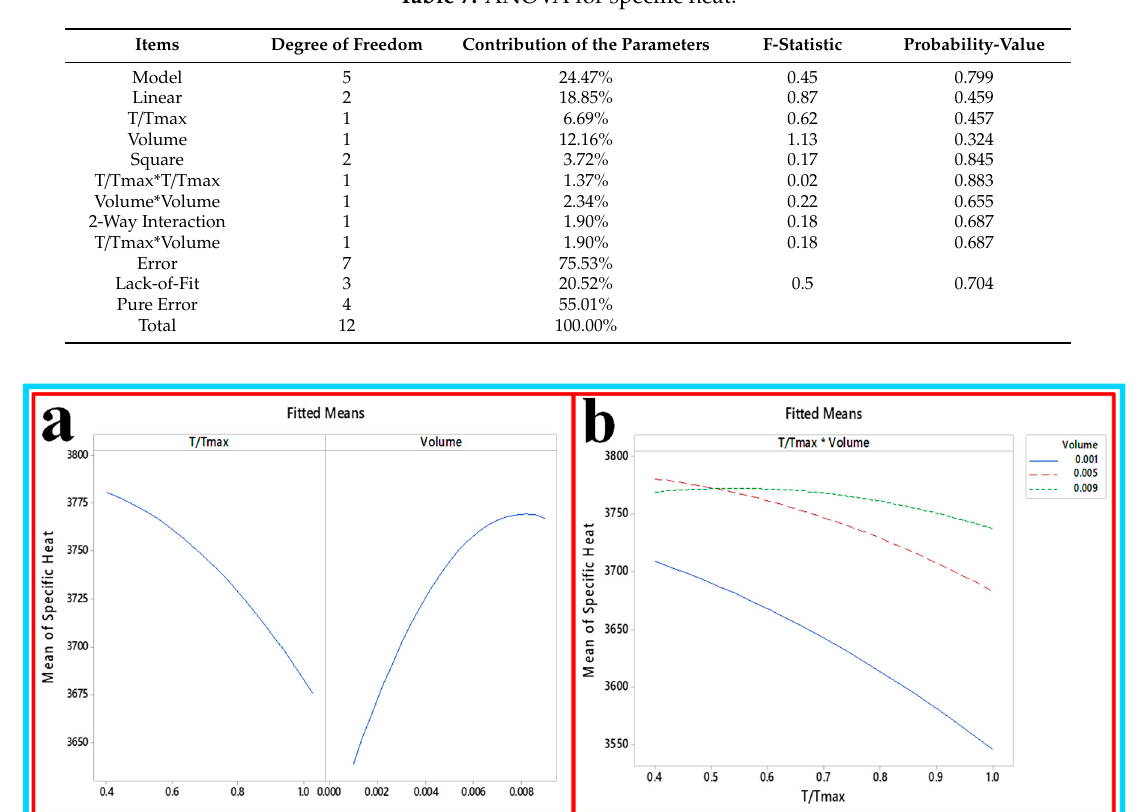
Figure 19. ( a ) Factorial plot and ( b ) interaction plot for the density.